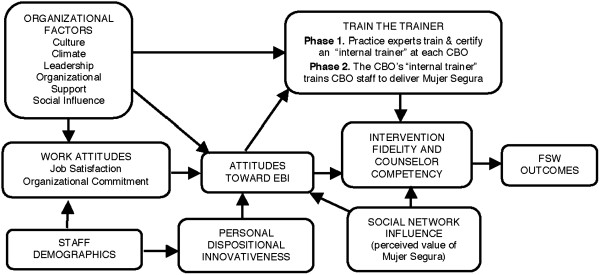
Organizational and provider factors influencing uptake, fidelity, and outcomes of evidence-based interventions (adapted from Aarons, 2005).